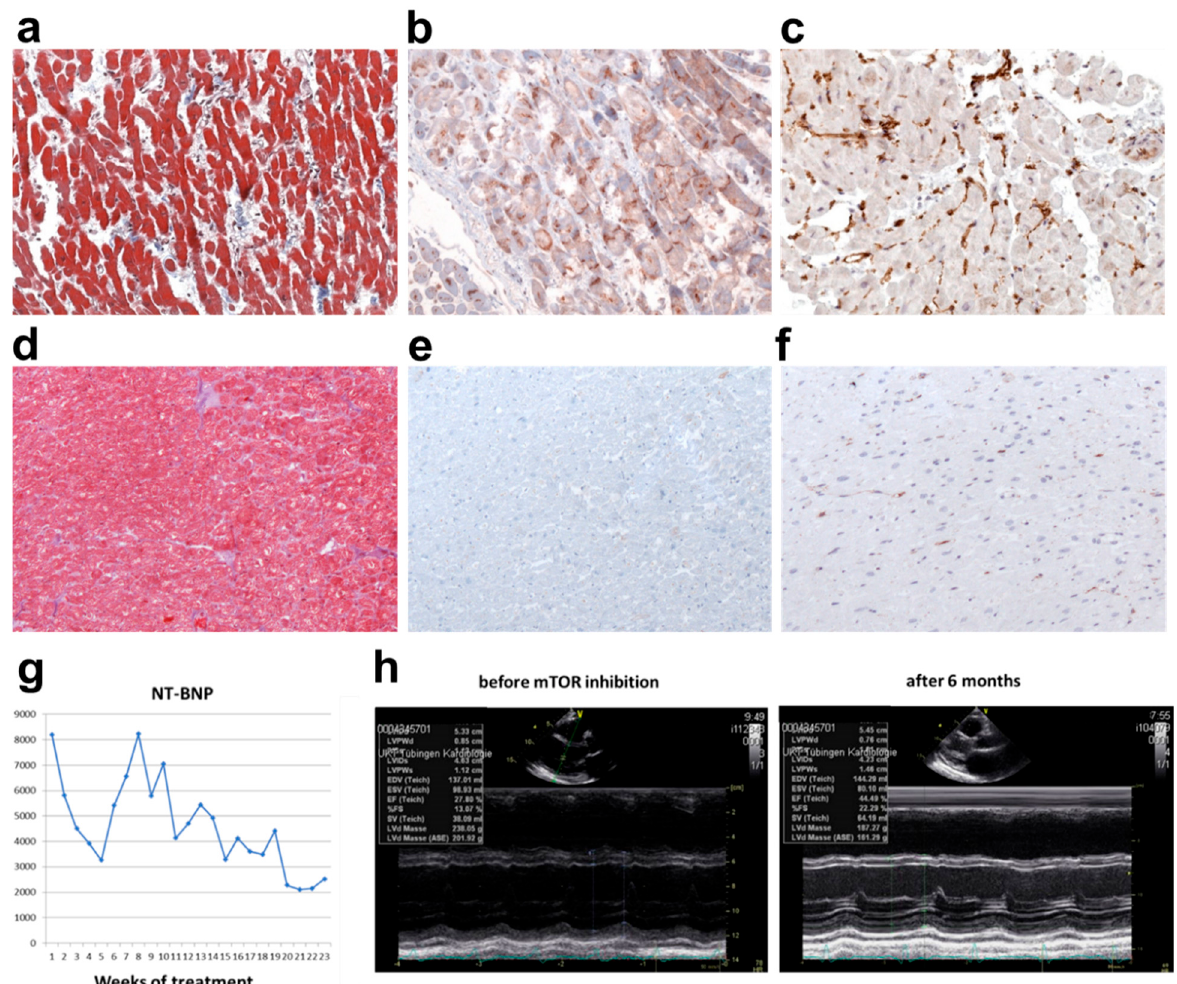
Figure 6. Patient biopsy data and treatment follow-up. Pathologic examination of patient biopsy from left ventricle was done with ( a ) Masson’s trichrome staining, ( b ) immunohistochemical stain- ing using anti-phospho-mTOR Ab and ( c ) HLA-DR staining, illustrating mostly macrophages. Corresponding Masson’s trichrome ( d ), anti-phospho-mTOR ( e ) and HLA-DR ( f ) stainings from a healthy, 61-year-old male revealing normal stainings in the myocardium. The LMNA -affected DCM patient was treated off-label with the mTOR-inhibitor rapamycin at a serum concentration of 8 ng/mL for 6 months as an off-label treatment. ( g ) NT-BNP serum concentration dropped from 8120 ng/L to 2210 ng/L. Measurements of NT-BNP levels at an interval of 1 week are shown. ( h ) Echocardiographic information before and 6 months after the rapamycin treatment. NT-BNP = N-terminal brain natriuretic peptide.